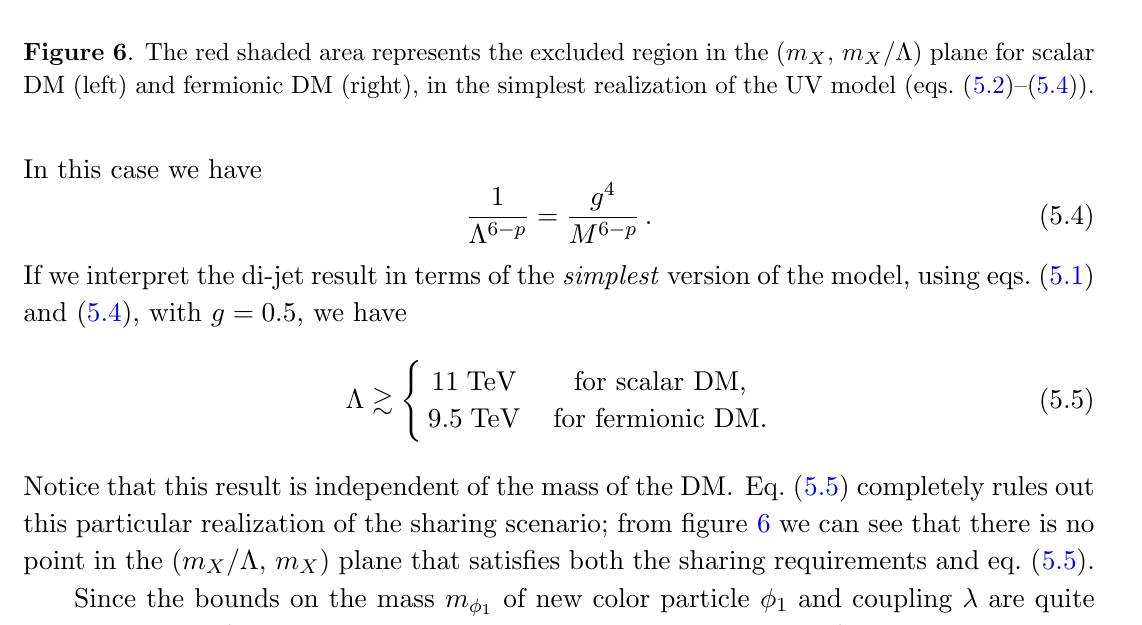
Figure 6 . The red shaded area represents the excluded region in the ( m X ; m X = (cid:3)) plane for scalar DM (left) and fermionic DM (right), in the simplest realization of the UV model (eqs.